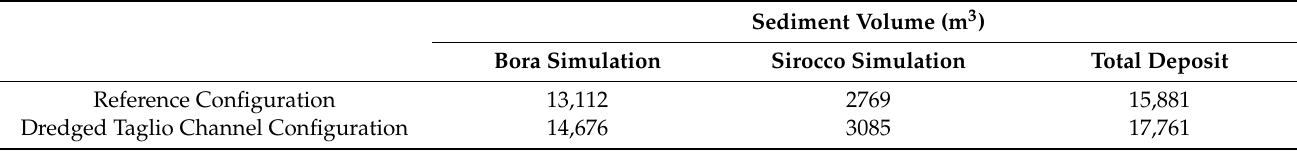
Table 5. Volumes of sediment deposits in the Marano port at the end of the simulated average